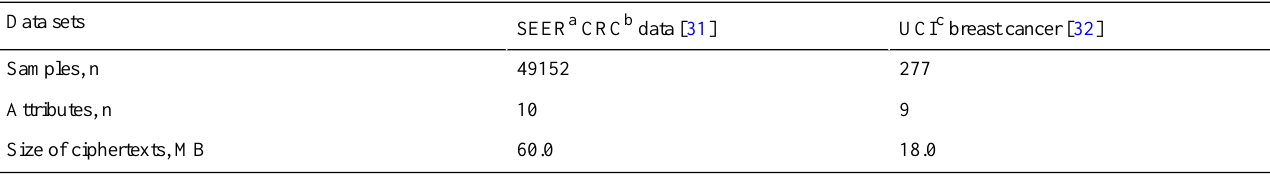
Table 1. Description of the data